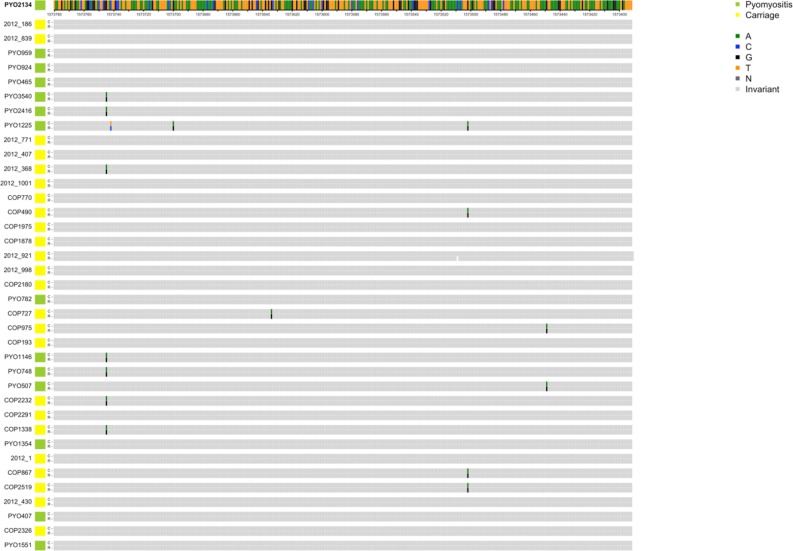
Alignments of reference genome PYO2134 assembly (R) with 37 de novo assemblies of Illumina short-read sequencing (C) which feature either ambiguities (Ns) or contig boundaries in the region 389 bp upstream of PVL coding sequence.Contig boundaries, when overlapping, are marked with a red diamond. Ns in the assembly are marked in dark grey. Polymorphisms are colour-coded by base.